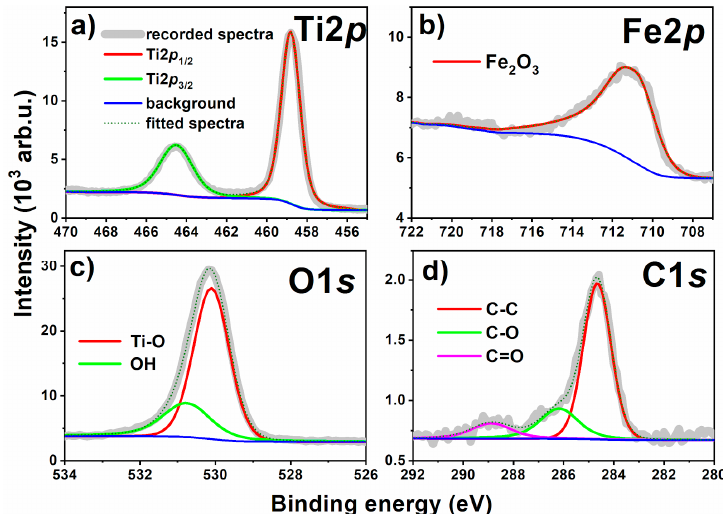
Figure 7. The XPS high resolution spectra registered for Fe10L80 sample: ( a ) titanium, ( b ) iron, ( c ) oxygen, and ( d ) carbon.